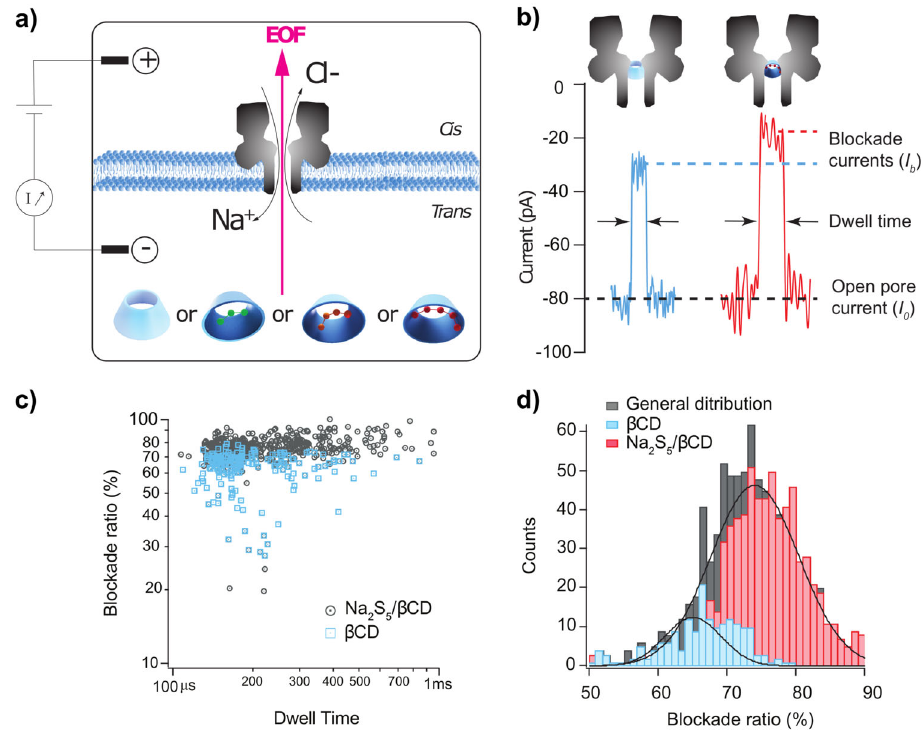
Fig. 4 Discrimination of Na 2 S 5 / β -cyclodextrin complex versus β -cyclodextrin using an α -hemolysin ( α -HL) nanopore. a Schematic of the ion − current measurement set-up. One protein nanopore is inserted into a suspended lipid bilayer. An electrical potential is applied via two Ag/AgCl electrodes, which induces an ionic current of Na + and Cl − ions through the nanopore (1 M NaCl, 25 mM NaHCO 3 pH 10, under argon atmosphere). At pH 10, the α -HL is anion selective (see Supplementary Fig. 15), consequently, an electro-osmotic fl ux (EOF) directed from trans to cis sets in favoring the entry of β - cyclodextrin and Na 2 S x / β -cyclodextrin into the stem part of the α -HL. b Detail of a part of current trace blockades arising from β -cyclodextrin (blue) and from Na 2 S 5 / β -cyclodextrin complex (red) interaction with the pore at − 100 mV. I 0 is the ionic open pore current and I b the blockade current. c Scatter plots of blockade ratio, given by the relation ð I 0 (cid:2) I b Þ = I 0 , versus dwell time in presence of 1 mM β -cyclodextrin (blue, 225 events) and 1 mM Na 2 S 5 / β - cyclodextrin complex solution (gray, 761 events) (5 independent experiments). d General distribution (gray) blockade ratio histogram in presence of 1 mM Na 2 S 5 / β -cyclodextrin complex (945 events). Deconvolution of the general distribution showing two populations attributed to β -cyclodextrin (blue, 64.0 ± 2.0%) and Na 2 S 5 / β -cyclodextrin (red, 74.0 ±